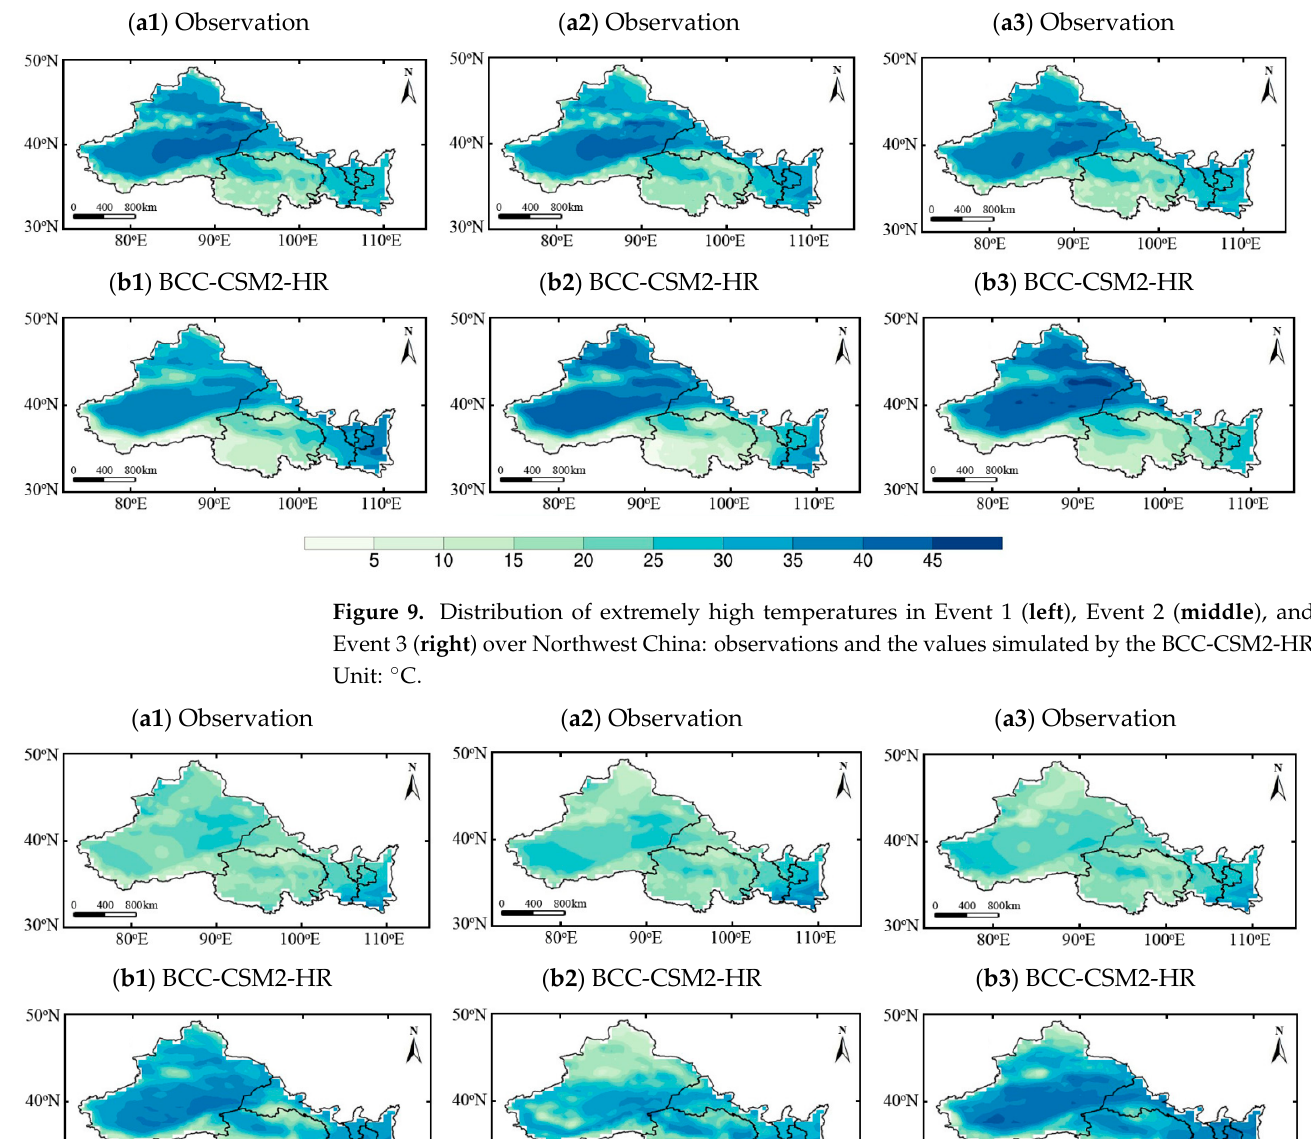
Figure 10. Distribution of extremely low temperatures in Event 1 ( left ), Event 2 ( middle ), and Event 3 ( right ) over Northwest China: observations and the values simulated by the BCC-CSM2-HR. Unit: °C.